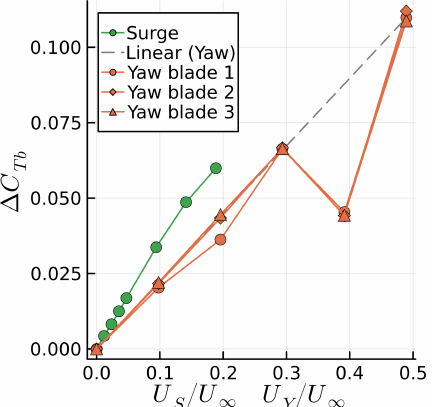
Figure 20. Amplitude of blade thrust coefficient fluctuations for various maximum surge velocities U S and maximum tip yaw veloc- ities U Y .